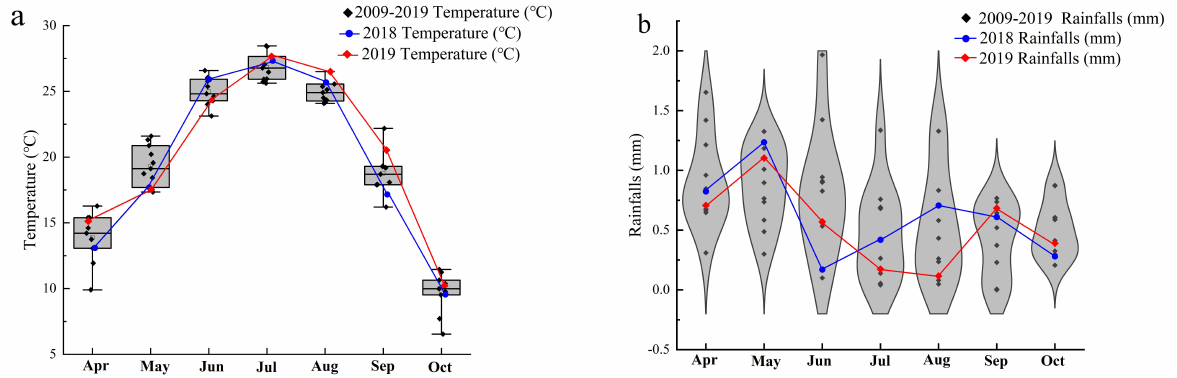
Figure 1. Summary of the monthly average meteorological data, ( a ) temperature, and ( b ) rainfalls from April to October in the experimental vineyards compared to the vintages from 2009–2019. The climate indices chosen for the analysis were described in Table 1. Growing season temperature (GST) is the mean air temperature of all days (from 1 April to 30